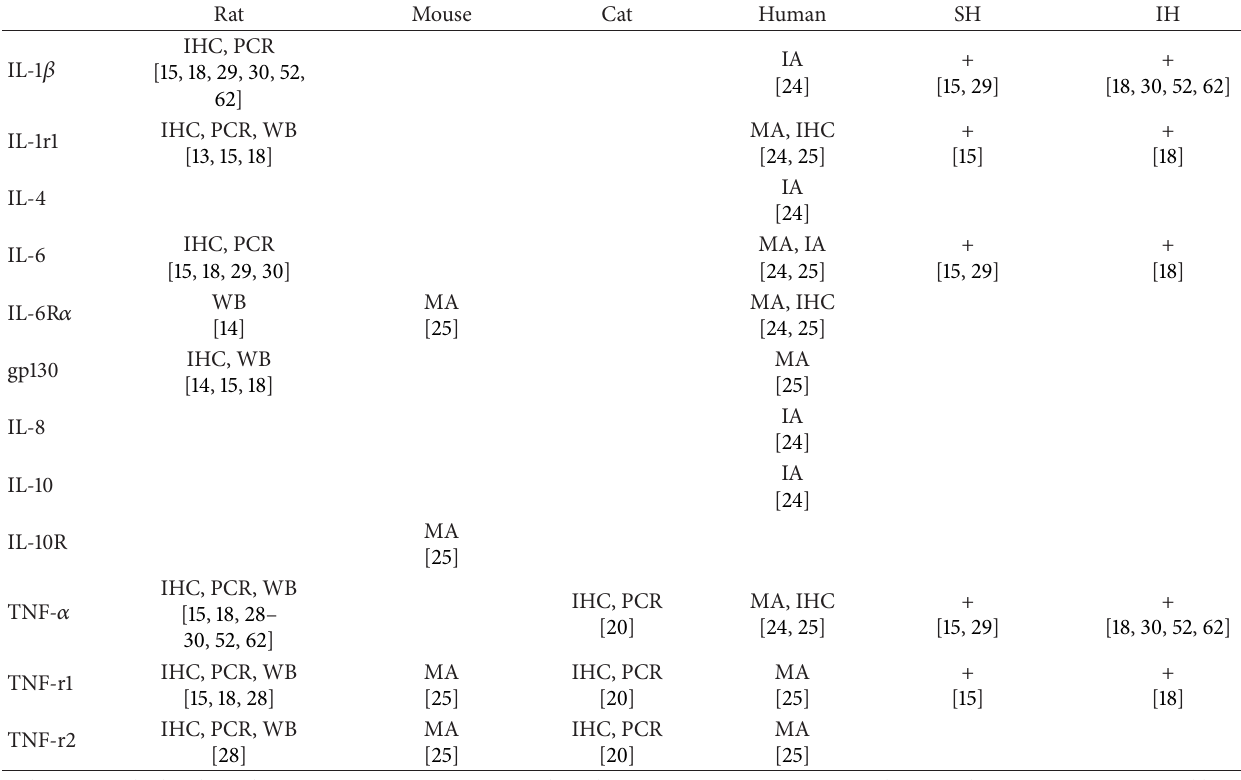
Table 1: A summary of main findings in literatures reporting the expression of cytokines and cytokine receptors in the carotid body of rodents, cats, and humans; also changes in the expression level under hypoxic conditions, namely, sustained hypoxia (SH) or intermittent hypoxia (IH) are